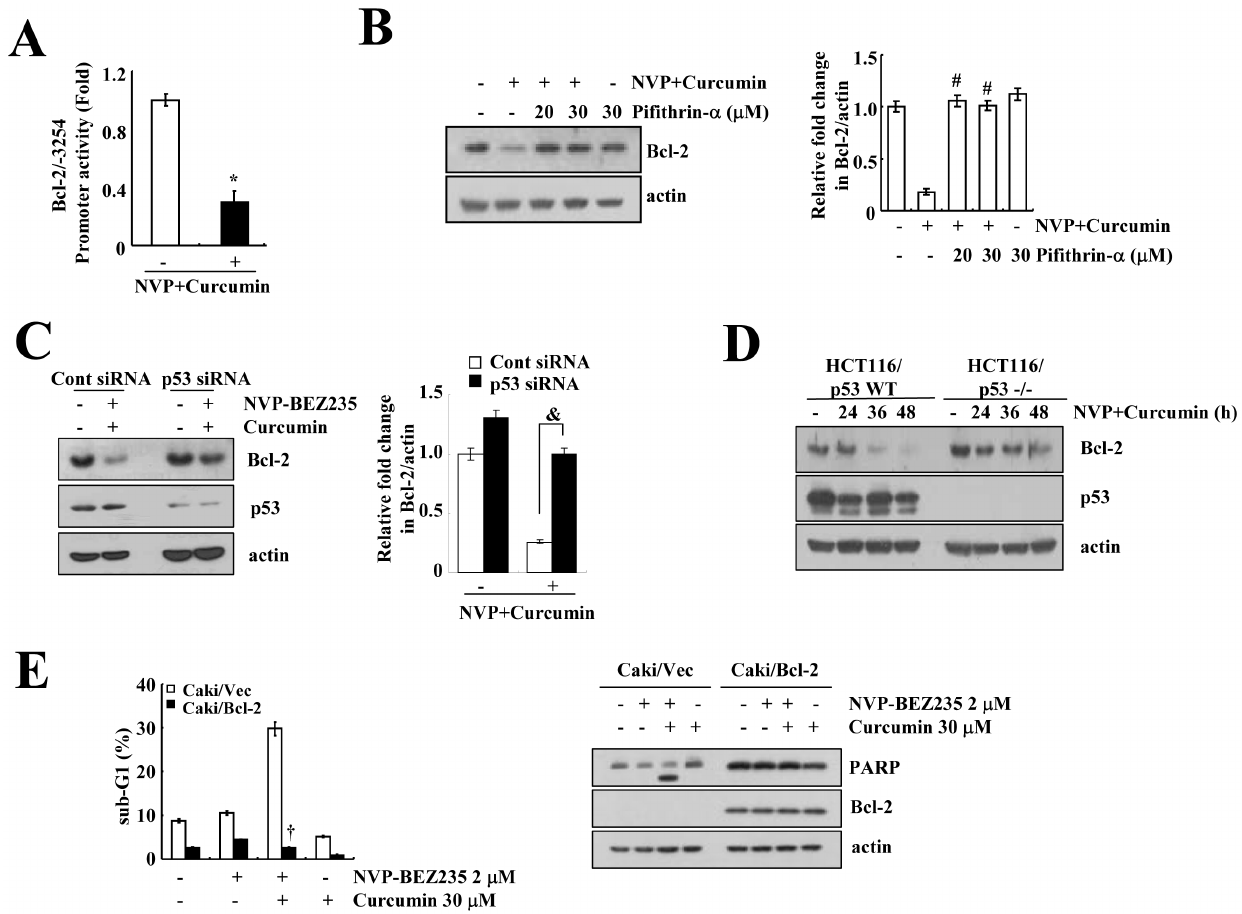
Figure 5. Combined treatment with NVP-BEZ235 (NVP) and curcumin decreased Bcl-2 expression in a p53-dependent manner. (A) Caki cells were transiently transfected with a plasmid harboring the luciferase gene under the control of the Bcl-2/ 2 3254 promoter. After transfection, the Caki cells were treated with 2 m M NVP-BEZ235 plus 30 m M curcumin for 48 h. After treatment, the cells were lysed, and the luciferase activity was analyzed. (B) Caki cells were pretreated with pifithrin- a for 30 min and were then treated with 2 m M NVP-BEZ235 plus 30 m M curcumin for 48 h. (C) Caki cells were transiently transfected with a control (Cont. siRNA) or p53 siRNA. Twenty-four hours after transfection, cells were treated with 2 m M NVP-BEZ235 plus 30 m M curcumin for 48 h. (D) p53 wild-type (HCT116/p53 + / + ) and p53-null HCT116 cells (HCT116/p53 2 / 2 ) were treated with 2 m M NVP-BEZ235 and 30 m M curcumin for the indicated time periods. (E) Cells that were transfected with the empty vector (Caki/Vec) and cells that over-expressed Bcl-2 (Caki/Bcl-2) were treated with 2 m M NVP-BEZ235 plus 30 m M curcumin for 48 h. The sub-G1 fraction was measured by flow cytometry. Equal amounts of cell lysate (40 m g) were subjected to electrophoresis and analyzed by western blotting for Bcl-2 (B, C, D, and E), p53 (C and D), PARP (E), and actin as a control for protein loading. The band intensities of Bcl-2 protein were measured using the public domain JAVA image- processing program ImageJ (B and C). The values in A, B, C, and E represent the mean 6 SD from three independent samples. * p , 0.001 compared to control. # p , 0.001 compared to 2 m M NVP-BEZ235 and 30 m M curcumin. & p , 0.001 compared to cont siRNA, which combined treated with 2 m M NVP-BEZ235 and 30 m M curcumin. { p , 0.001 compared to Caki/Vec, which combined treated with 2 m M NVP-BEZ235 plus 30 m M curcumin. The data represent three independent